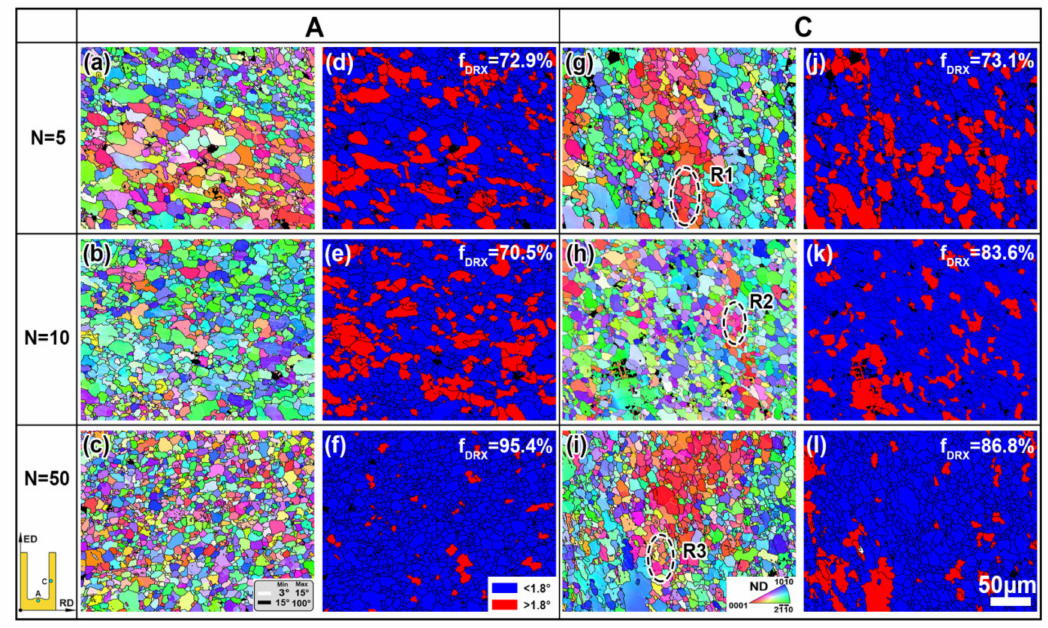
Figure 5. The inverse pole figure (IPF) and corresponding grain orientation spread (GOS) maps of the RBE samples at the two di ff erent locations: ( a , d , g , j ) n = 5, ( b , e , h , k ) n = 10, and ( c , f , i , l ) n = 50. (For interpretation of the references to color in this figure legend, the reader is referred to the Web version of this